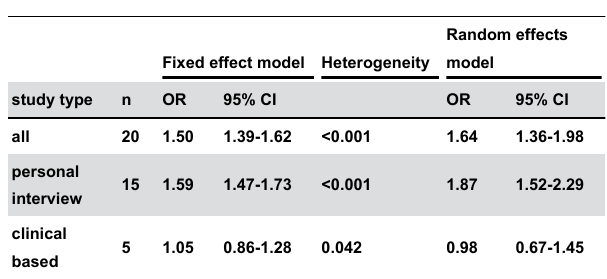
Table 4. Pooled Odds Ratio for prostate cancer and prostatitis by countries.